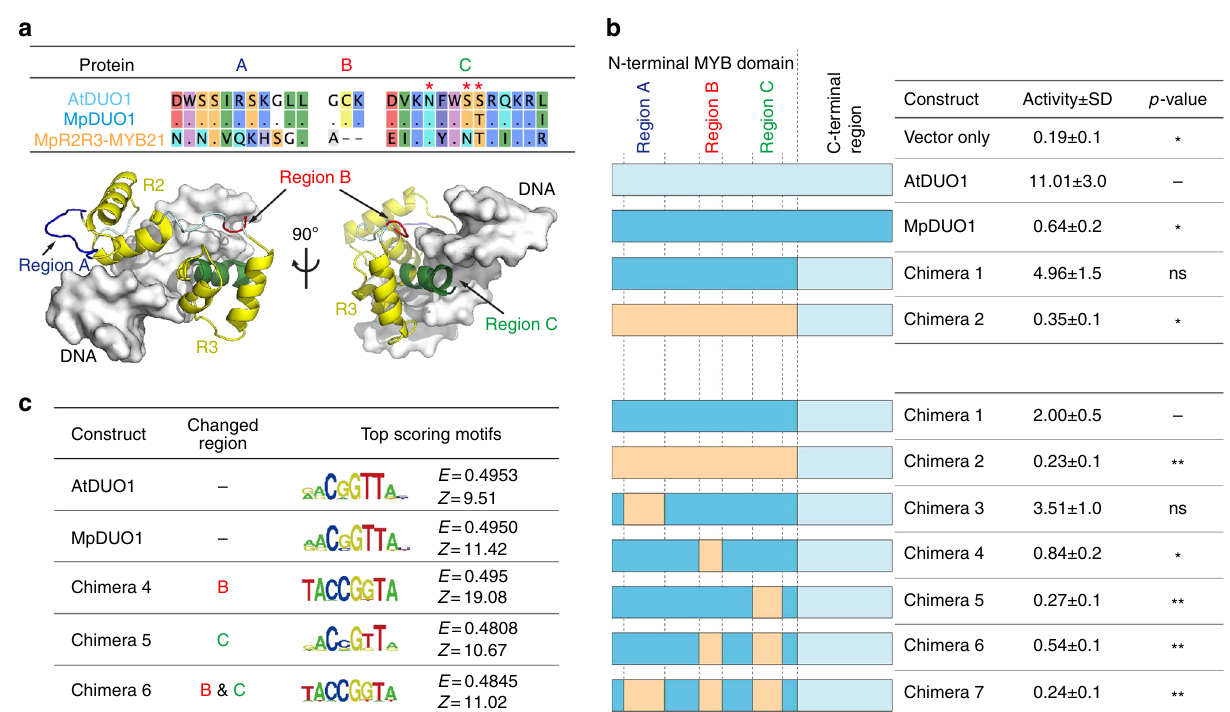
Fig. 4 Characterization of DUO1 transcription factor activity. a Amino acid sequence alignment of regions A, B, and C among AtDUO1, MpDUO1, and MpR2R3-MYB21 (top). Dots indicate matching residues with AtDUO1. Asterisks indicate putative DNA-interacting residues in region C. Structural modeling of MpDUO1 in complex with DNA using SWISS-MODEL (bottom). The MpDUO1 MYB domain is overlaid onto the structure of the AMV v-MYB- DNA complex (PDB code: 1H8A). b in vivo transcriptional activation potentials of MpDUO1 and chimeras. Schematic diagram of constructs (left) are color- coded light blue (AtDUO1), dark blue (MpDUO1), and orange (MpR2R3-MYB21). DUO1 transcriptional activation potentials were measured by relative luciferase activity (right). n = 4 (upper), n = 8 (lower) (** p < 0.01; * p < 0.05; ns not signi fi cant; Student ’ s t- test). c Position weight matrix representations of the top-scoring 8-mer DNA sequences bound by different MYB domains on a protein-binding DNA microarray. Numbers denoted on the right side of each motif represent the motif E- and Z-scores